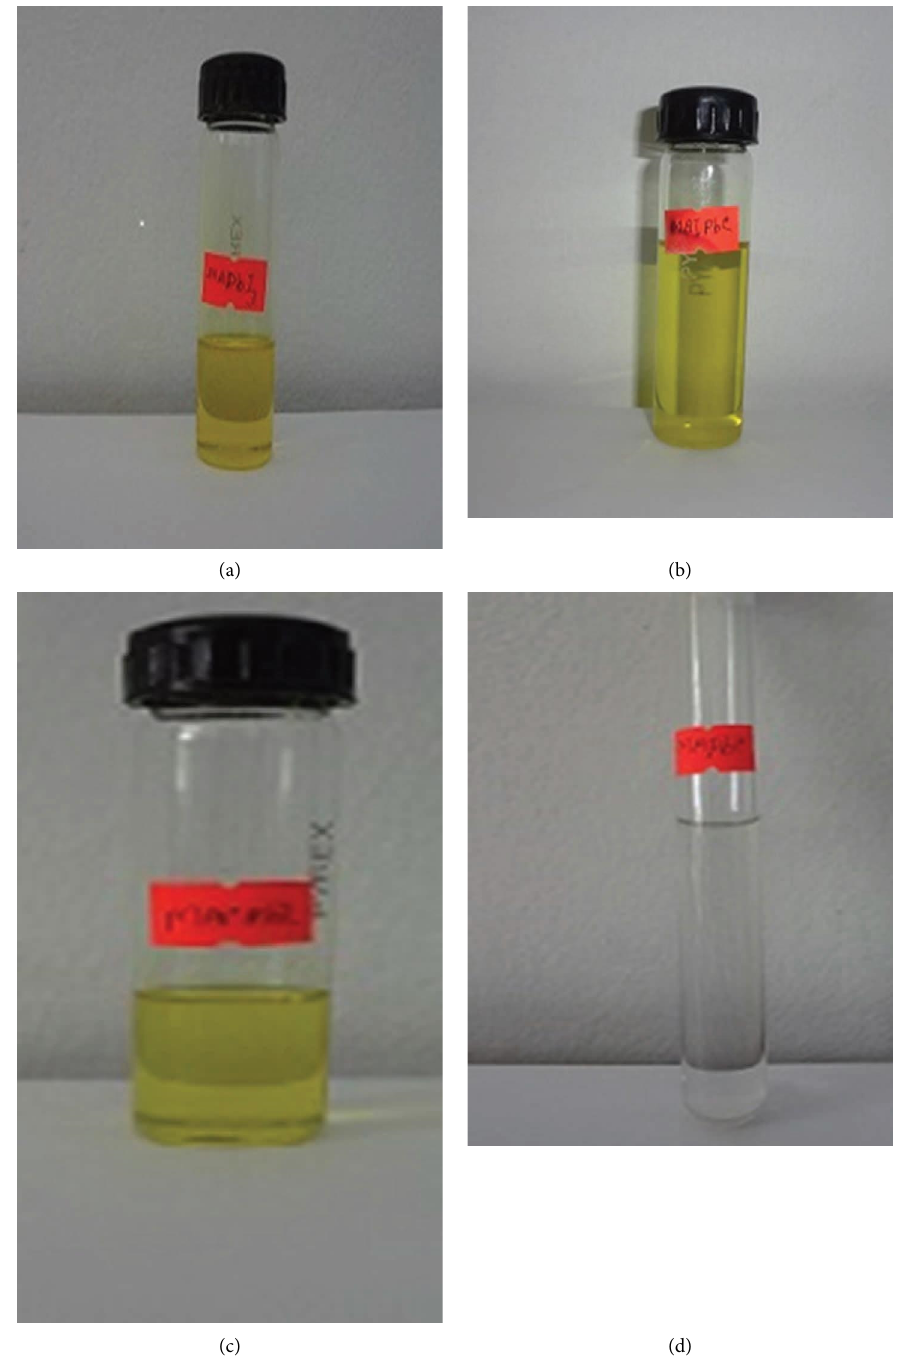
Figure 1: Synthesized (a) CH 3 NH 3 PbI 3, (b) CH 3 NH 3 ClPbI 2, (c) CH 3 NH 3 IPbCl 2 , and (d) CH 3 NH 3 PbCl 3 precursor